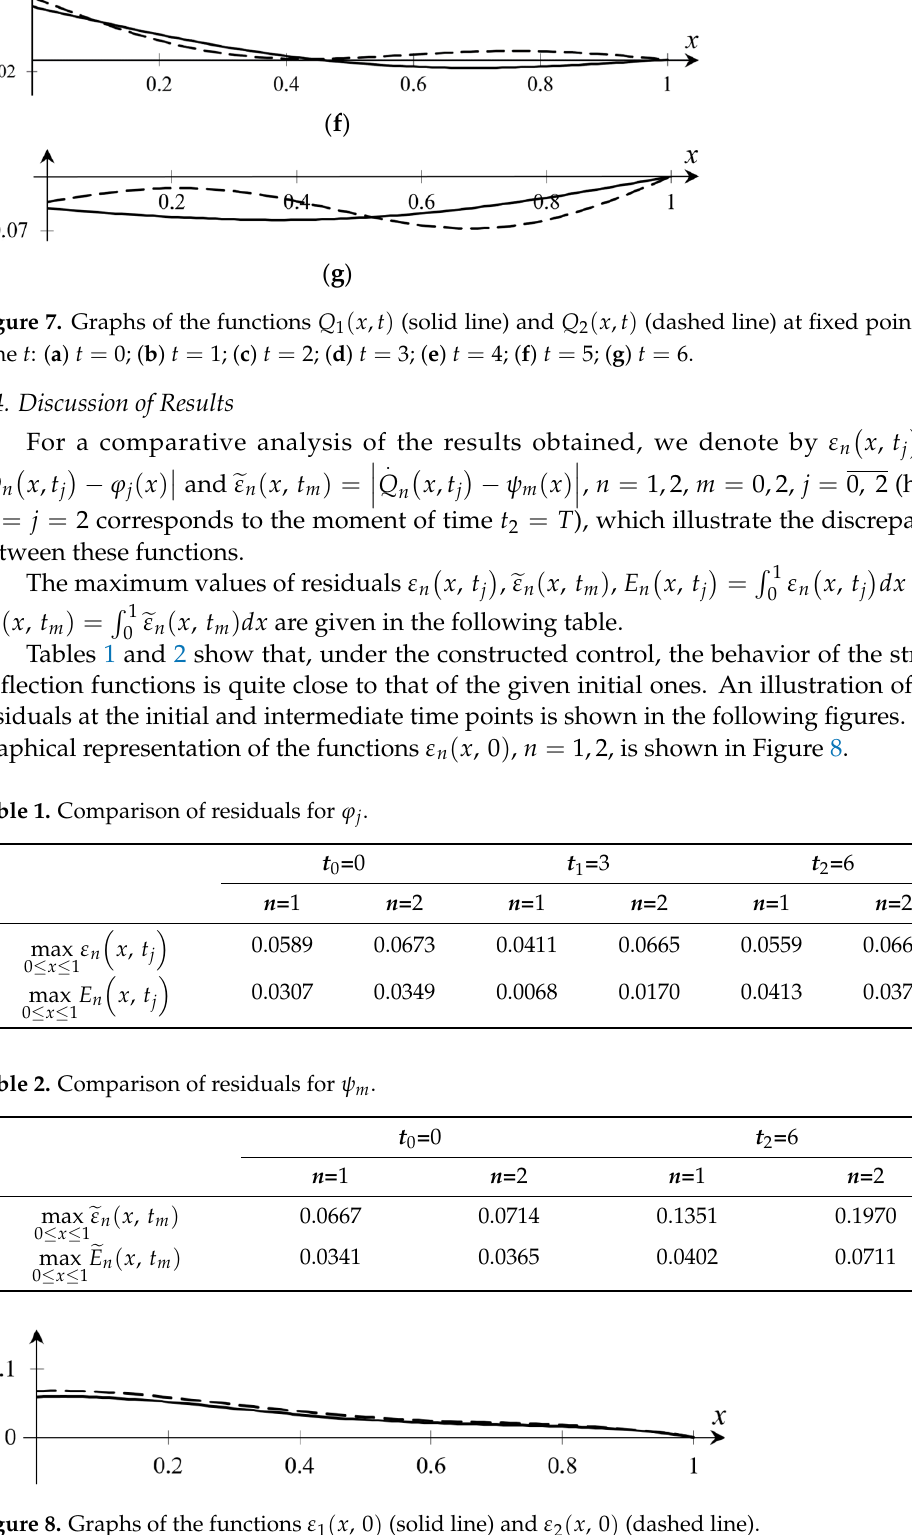
Figure 7. Graphs of the functions 𝑄 (cid:2869) (cid:4666)𝑥, 𝑡(cid:4667) (solid line) and 𝑄 (cid:2870) (cid:4666)𝑥,𝑡(cid:4667) (dashed line) at fixed points in